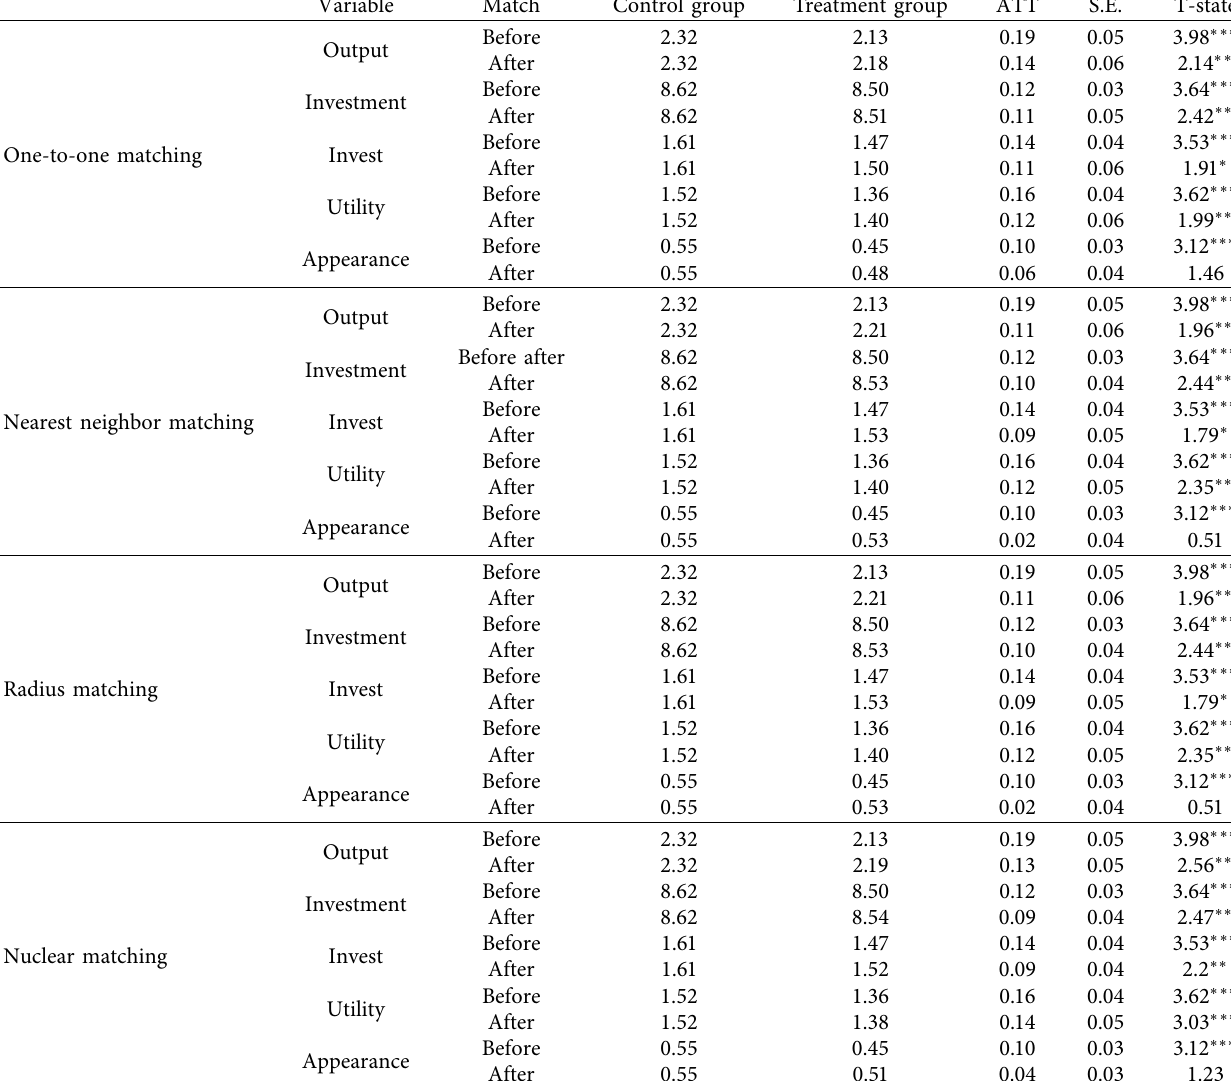
Table 5: The average treatment effect of the sample population. Variable Match Control group Treatment group